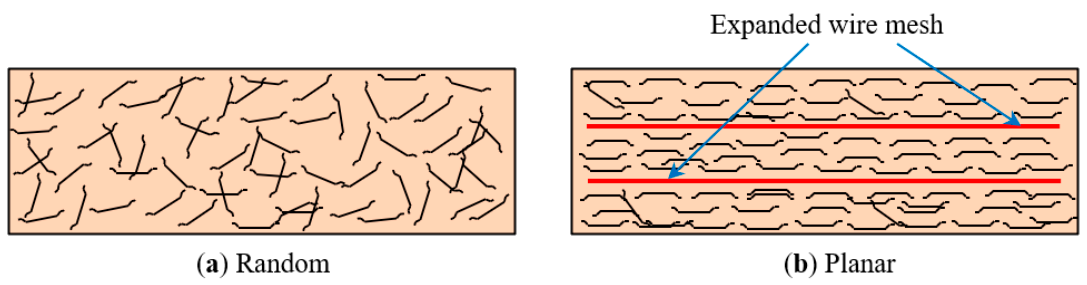
Figure 14. Distribution of fibers in ferrocement panel: ( a ) random and ( b ) planar.